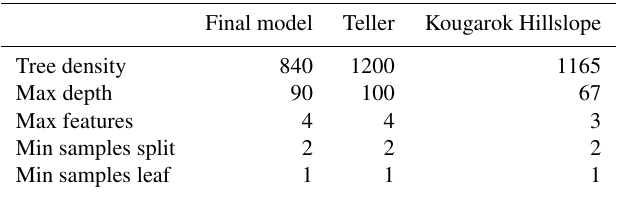
Table A3. Hyperparameters for the random forest